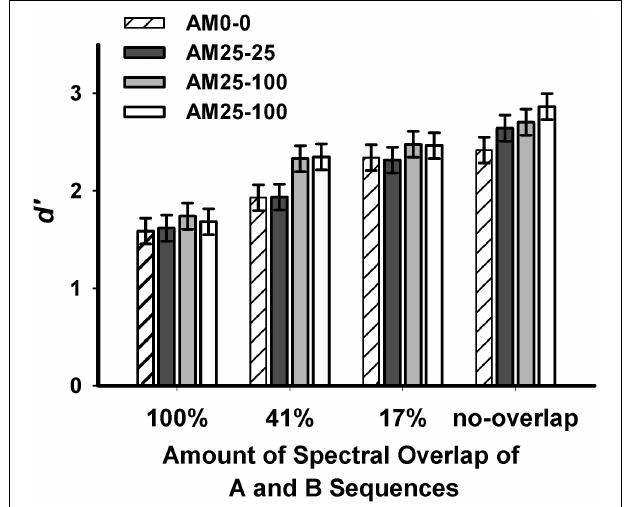
FIGURE 2 | Mean d ′ -values in various spectral and AM-rate conditions of the stimuli sequences collapsed across the 12-pair sequence duration in Experiment 1 (error bars represent ± 1 standard errors around the